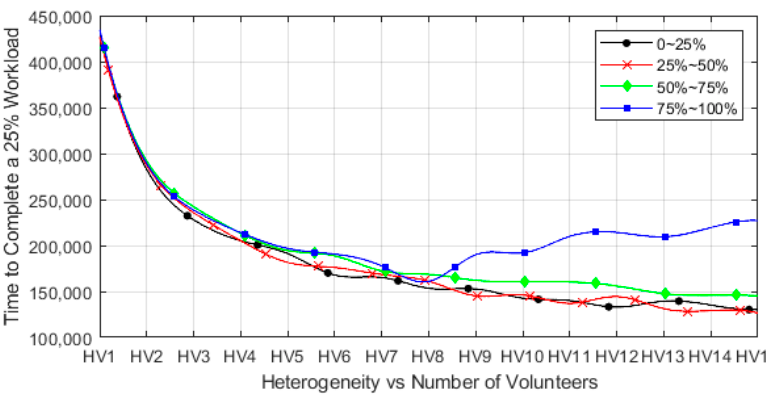
Figure 6. The time to complete a 25% workload vs. evaluation pairs.